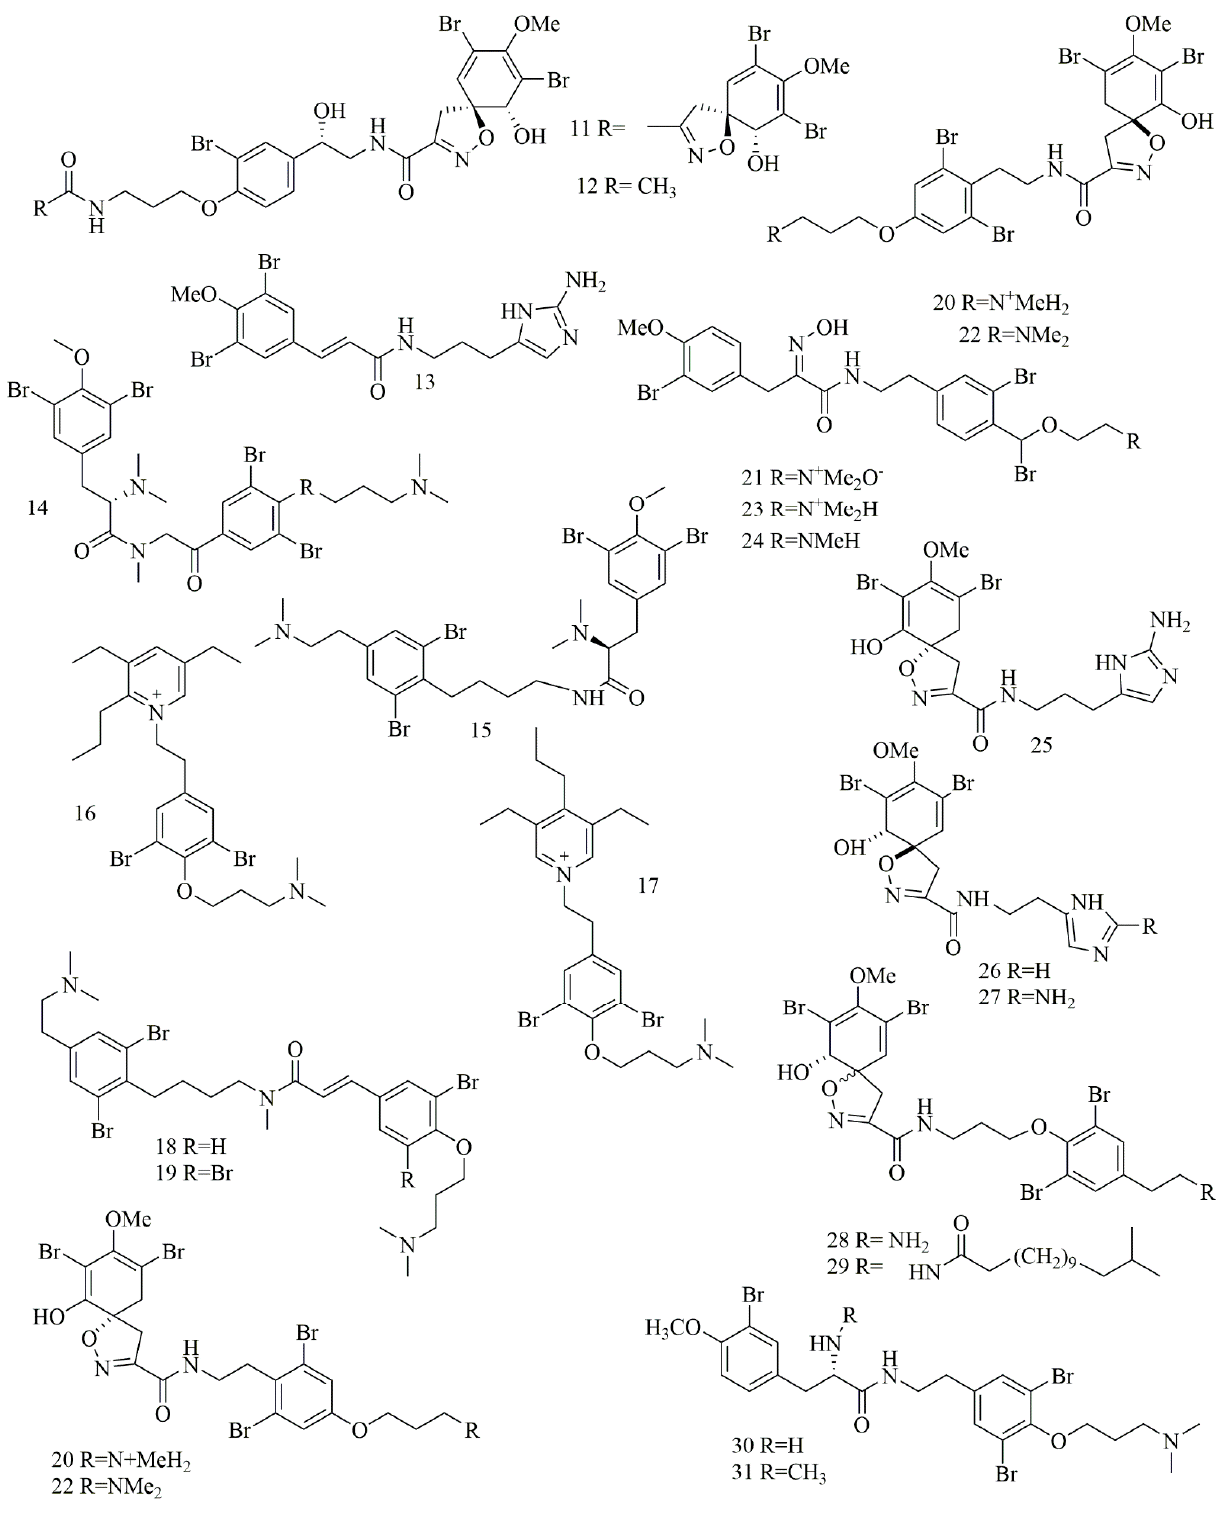
Figure 3. Structures of bromotyrosine alkaloids isolated from sponges.